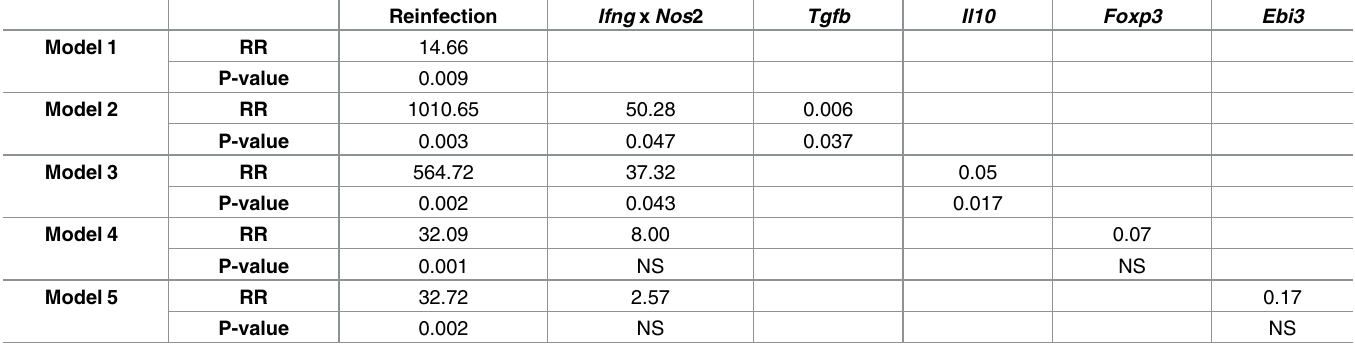
Table 2. Multivariate logistic regression analysis of different factors obtained in the course of experimental fascioliasis in Wistar rats and regres- sion coefficients [Exp(B) = RR = relative risk of presenceof anemia] with significance in different